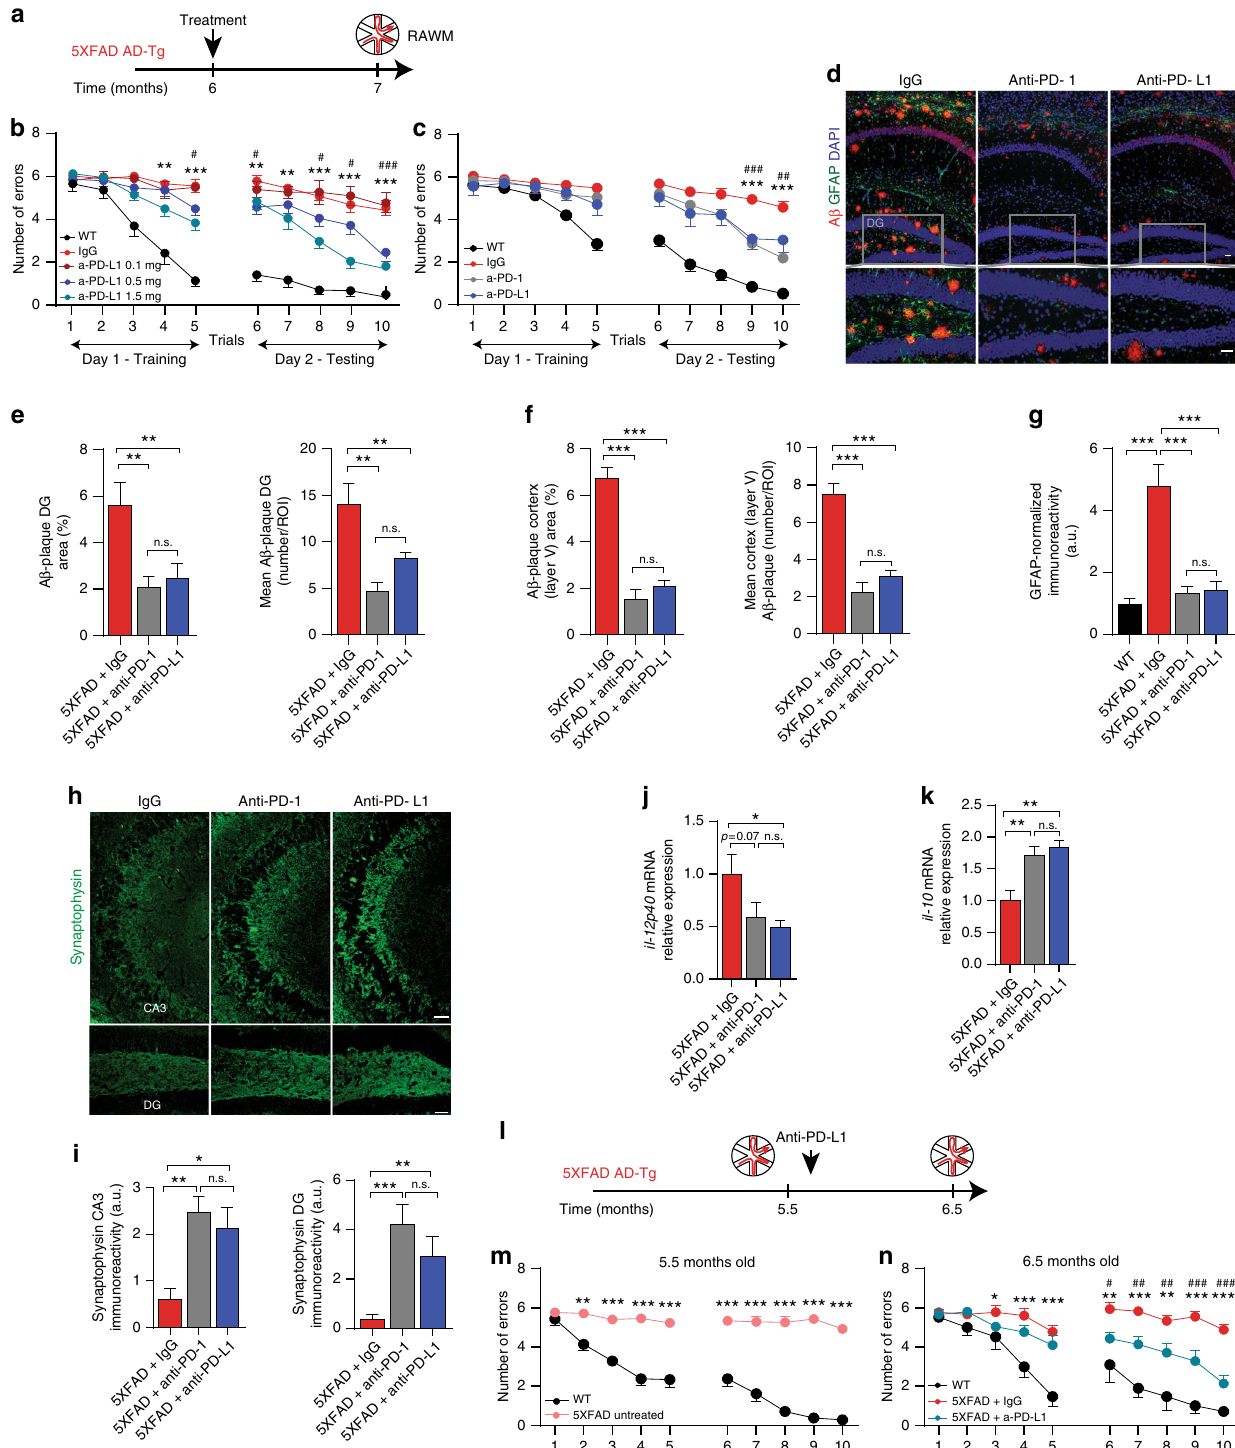
whether the ef fi cacy of anti-PD-L1 is dependent on the antibody dosage in these animals. To this end, DM-hTAU mice were treated with a single injection of anti-PD-L1 at 0.1, 0.5, or 1.5 mg/ mouse, relative to a single injection of 1.5 mg/mouse IgG2b control antibody. WT littermates were used as a control for intact cognitive performance. Results are presented as the time spent in the novel arm, revealing that 0.1 mg of anti-PD-L1 antibody was ineffective, while dosages of 0.5 or 1.5 mg were both effective in improving cognitive performance (Fig. 3b – d). Treatment with